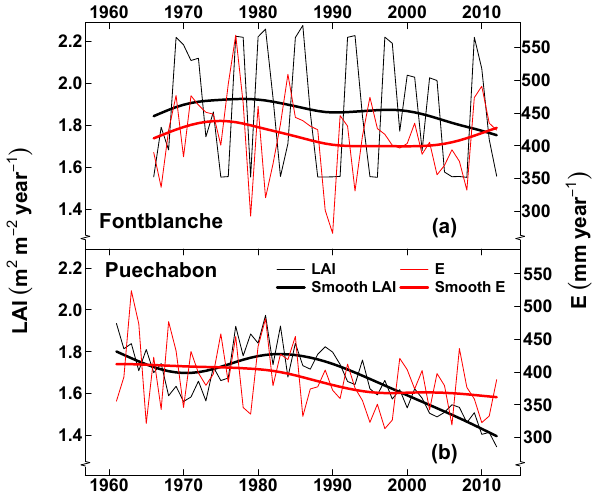
Figure A3. Simulated maximum annual leaf area index LAI (m 2 m − 2 ) and total annual stand transpiration E (mmyr − 1 ) in Fontblanche (a) and Puechabon (b) .